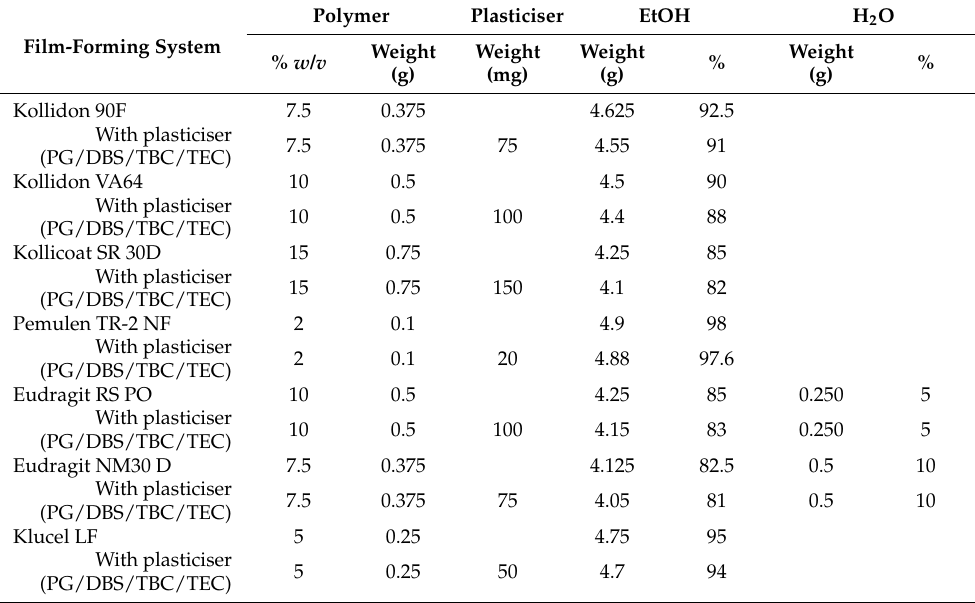
Table 1. Composition of the placebo film-forming system